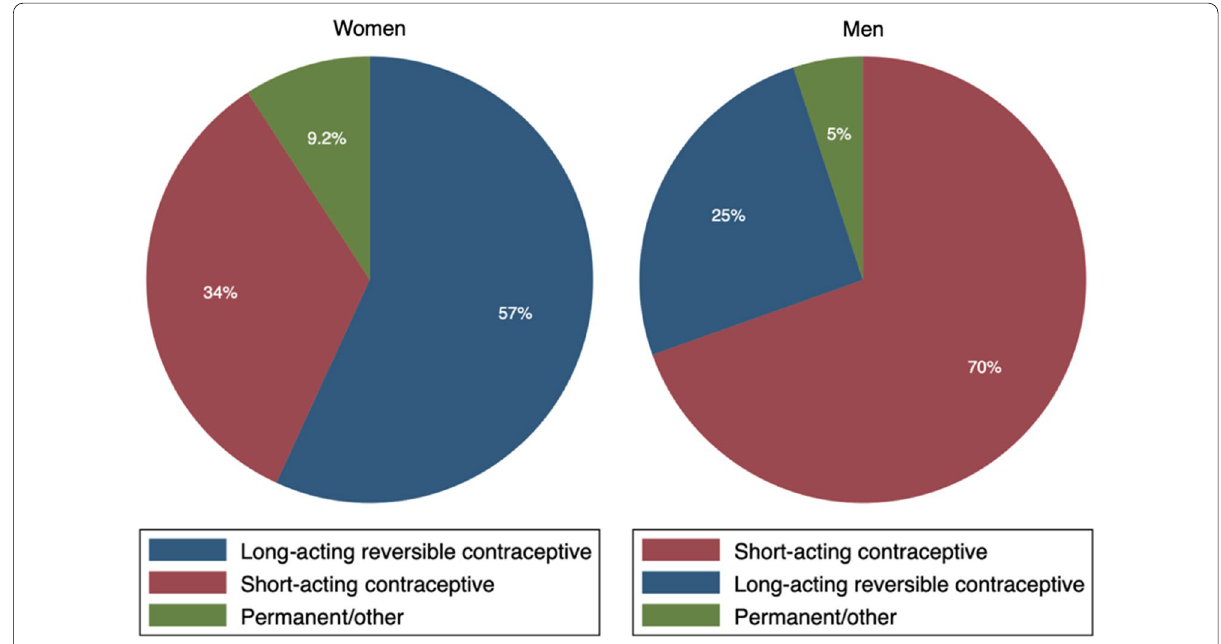
Fig. 2 Choice of modern method of contraception by